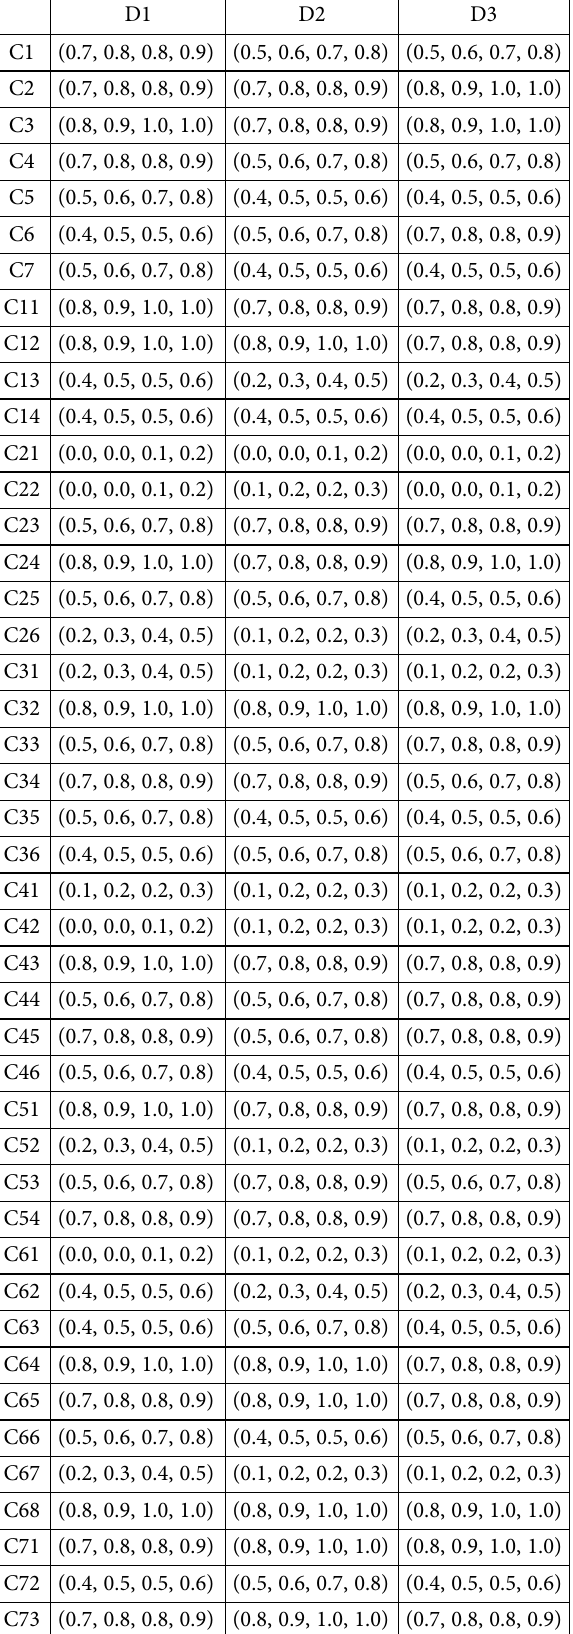
Table 5. Importance weight of the criteria assessed by